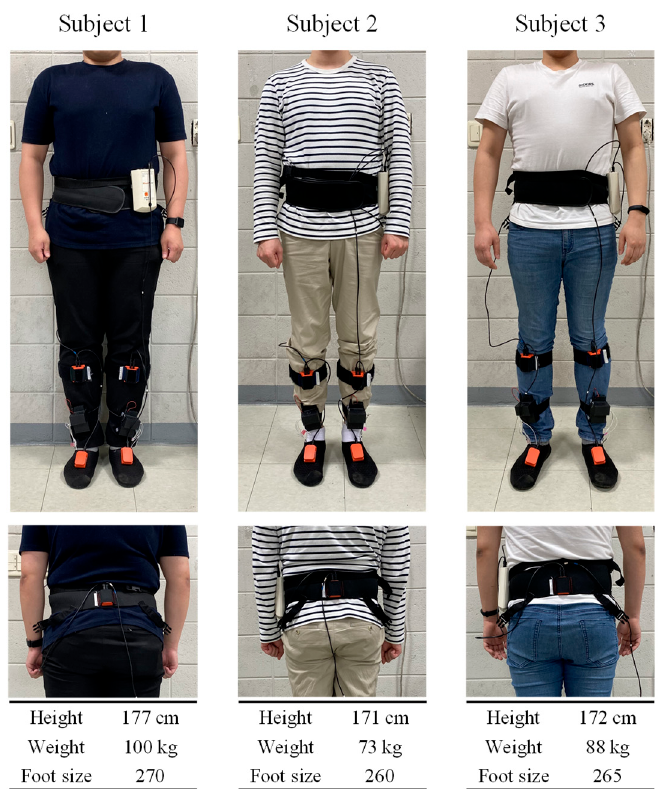
Figure 10. Experimental environment and subject information.